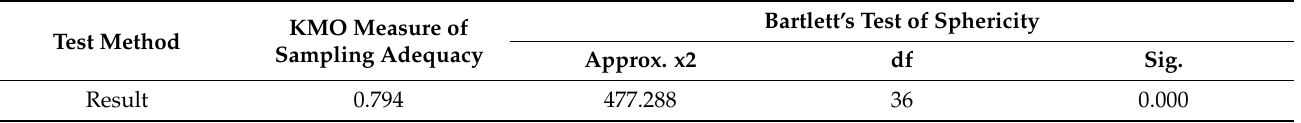
Table 3. KMO and Bartlett’s correlation test.